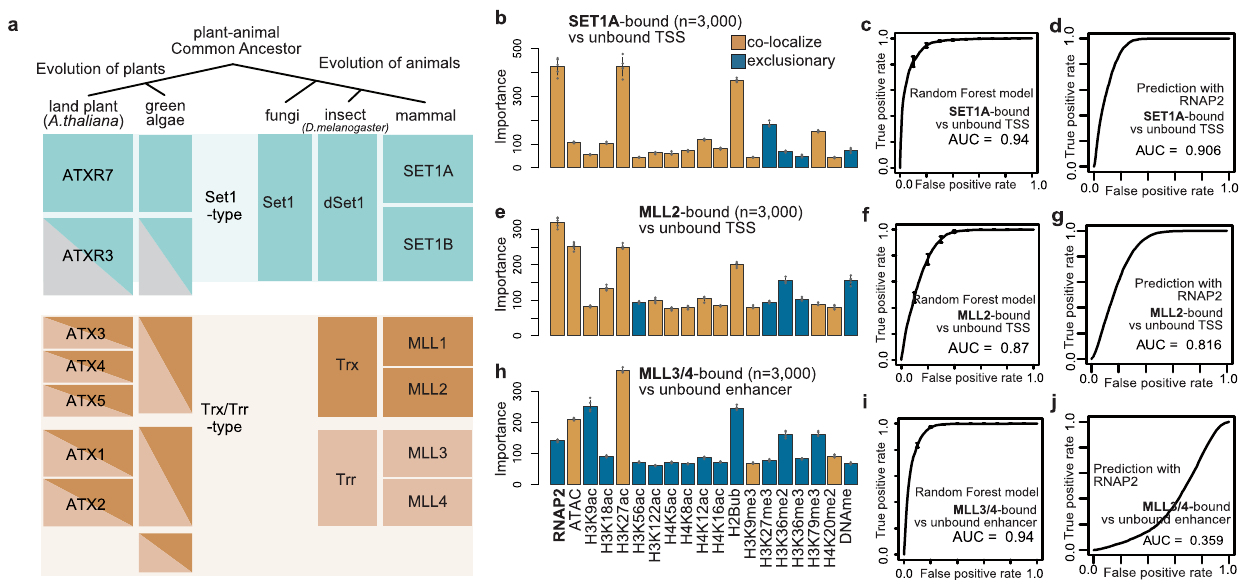
Fig. 7 | Localization and functional mode of mammalian H3K4 methyl- transferases. a Evolution of H3K4 methyltransferases in eukaryotes based on 18,43 . b , e , h ChromatinfeaturespredictiveofthelocalizationsofSET1A( b )andMLL2( e ) attheTSSregions,andMLL3/4( h )attheenhancerregions.Barsarecoloredbrown if the mean abundance of the feature is bound region > unbound region (i.e. colocalize), and colored blue otherwise (i.e. exclusive). Error bars are the standard